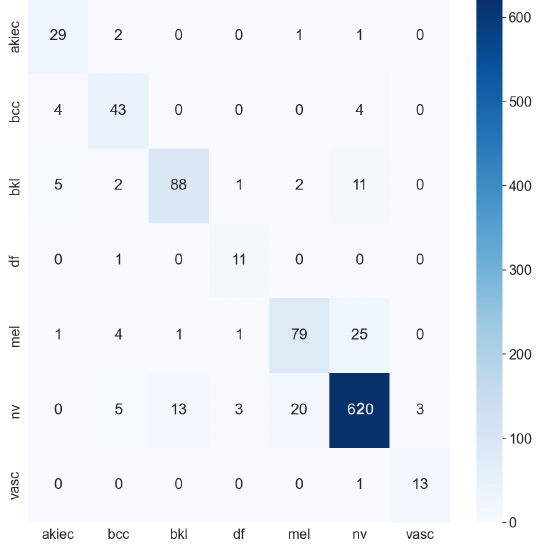
Figure 11. InceptionResNetV2 confusion